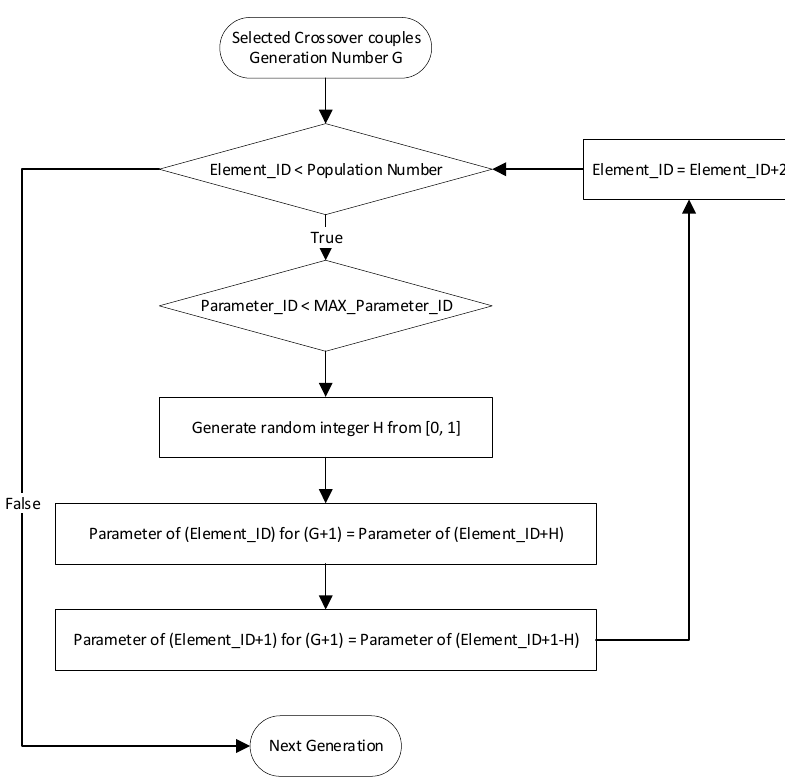
Figure 4. Schematic of crossover method implemented in the algorithm.